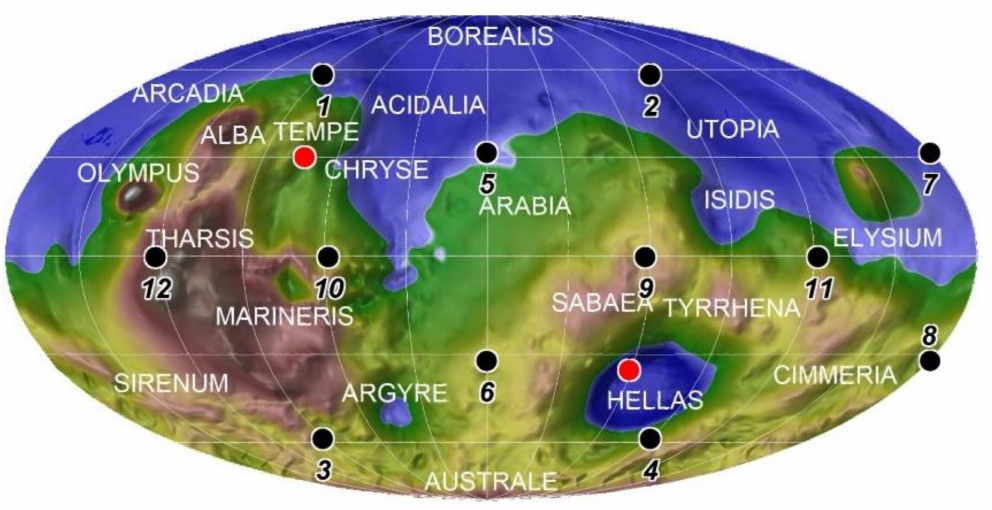
Figure 10. Elevation data showing twelve pentagon centroids (black dots with numbers from 1 to 12) and two selected points